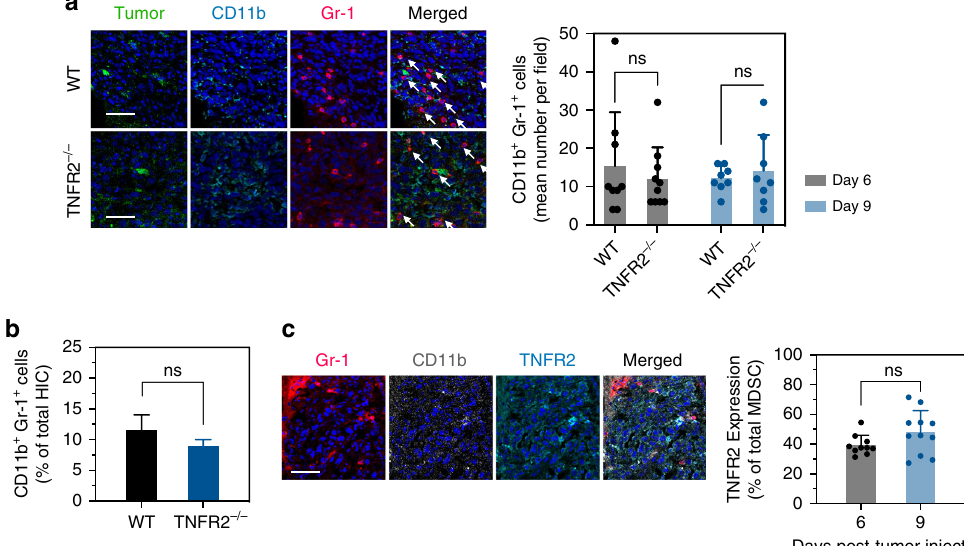
Fig. 2 Loss of TNFR2 expression does not affect MDSC accumulation in male mice. Livers were resected at the indicated time intervals postintrasplenic/ portal injection of 5 × 10 5 GFP-tagged MC-38 cells (green) ( a , c ) or 5 × 10 4 MC-38 cells ( b ), 14 μ m frozen sections prepared and immunostained with the indicated antibodies followed by Alexa Fluor 568 (red) for Gr-1, and Alexa Fluor 647 (cyan) or Alexa Fluor 700 (white) for CD11b and Alexa Fluor 647 (cyan) for TNFR2. Shown in a (left) are representative images of 20 fi elds acquired for each experimental group ( n = 3, day 9) and in a (right) the mean numbers (±s.e.m.) of CD11b + Gr-1 + cells enumerated in each group at the indicated time intervals following tumor injection. Shown in b are results of FC performed on immune cells isolated 9 days post tumor injection and immunostained with the indicated antibodies. They are expressed as means (±s.e.m.) of three separate analyses, each performed on livers obtained from six mice per group. Shown in c (left) are representative images of TNFR2 + CD11b + Gr-1 + cells visualized in 30 fi elds in sections derived from male mice inoculated with MC-38 cells 9 days earlier and in c (right) the results expressed as % TNFR2 + cells (±s.e.m.) of total CD11b + Gr-1 + cells counted per fi eld in sections derived at the indicated time intervals following tumor injection. NS, not signi fi cant as determined by the a two-tailed Student's t -test. Scale bars correspond to 100 µ m on histology